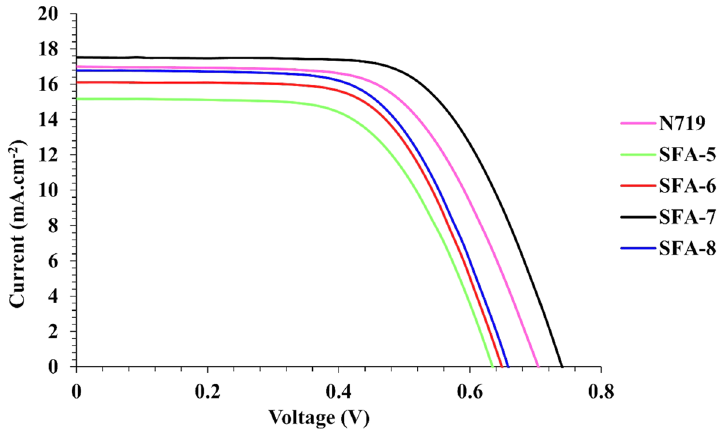
Figure 11. Current density–voltage characteristics for DSSCs based SFA-5–8 and N-719